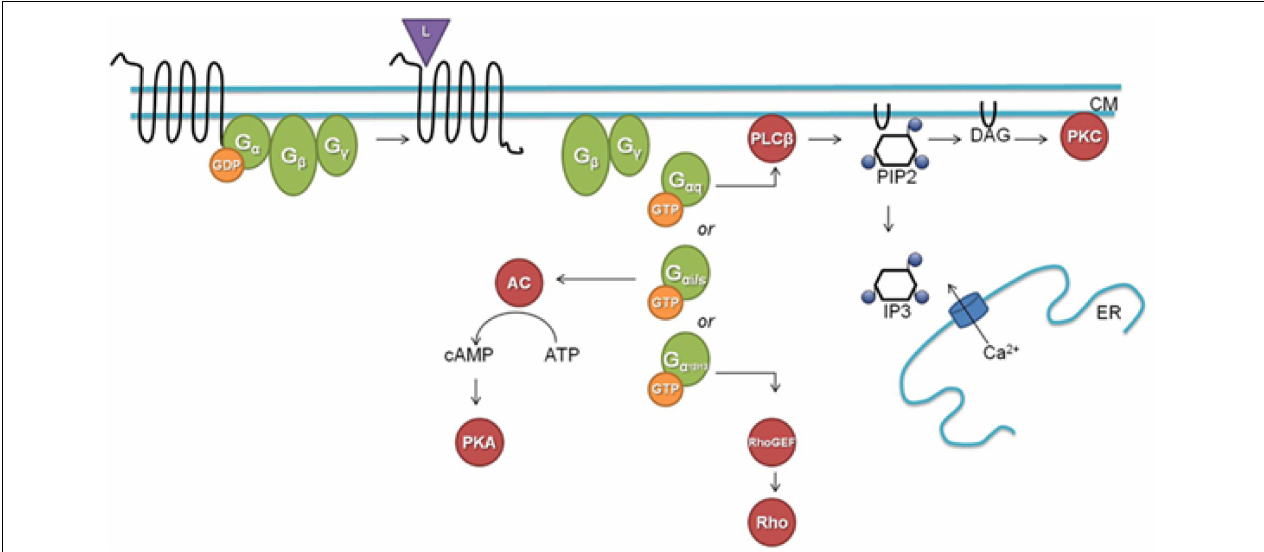
FIGURE 5 | A classical downstream G protein signaling pathway (L, ligand; CM, cell membrane; GDP, guanosine diphosphate; GTP, guanosine triphosphate; AC, adenylate cyclase; cAMP, cyclic adenosine monophosphate; ATP, adenosine triphosphate; PKA, protein kinase A; PLC β , phospholipase C β ; PIP2, phosphatidylinositol 4,5-bisphosphate; DAG, diacylglycerol; IP3, inositol-1,4,5-trisphosphate; ER, endoplasmatic reticulum; Rho, Rho factor; PKC, protein kinase C; GEF, guanine nucleotide exchange factor). Figure and legend borrowed from Frooninckx et al. (2012), Open